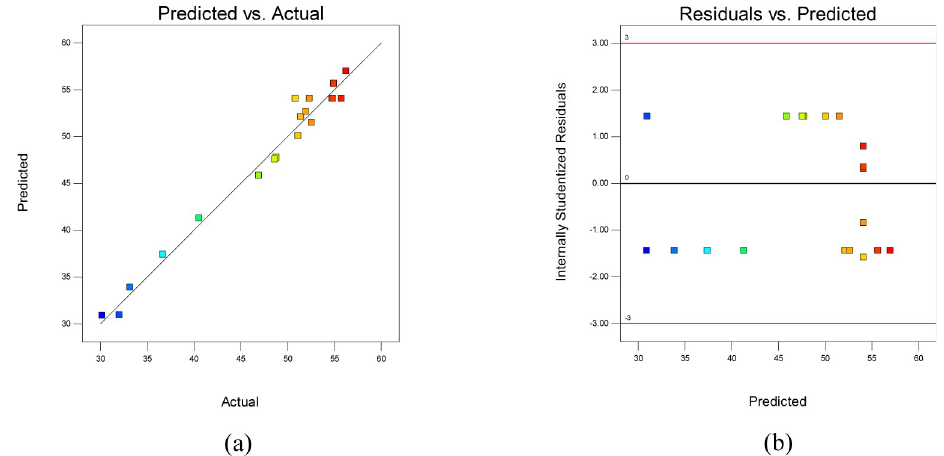
Fig 2. Statistical analysis of the model. (a) Comparison of actual and predicted response values. (b) Comparison of internally studentized residuals and predicted response values.